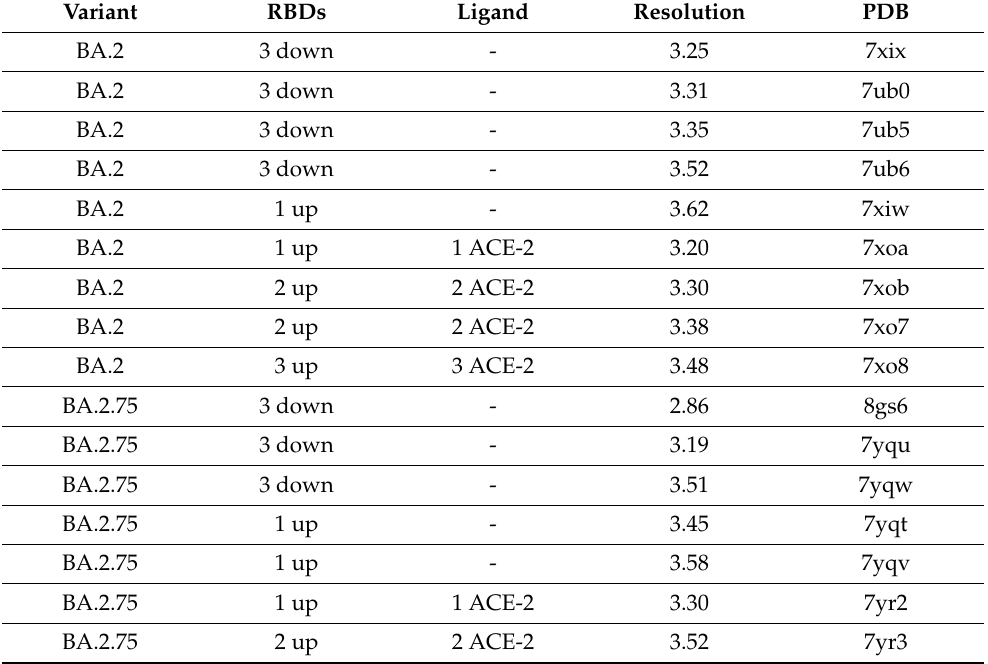
Table 2. Structures of the S Omicron BA.2 and BA.2.75 variants.